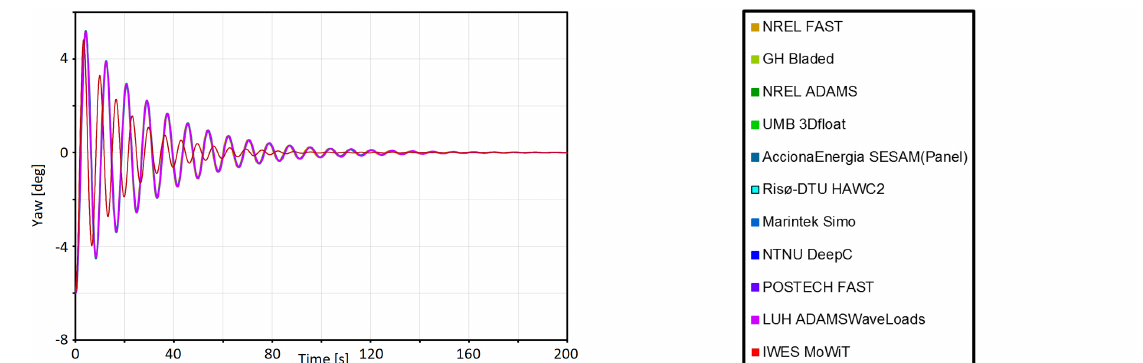
Figure 10. Free-decay time series in platform pitch from LC 1.4e.